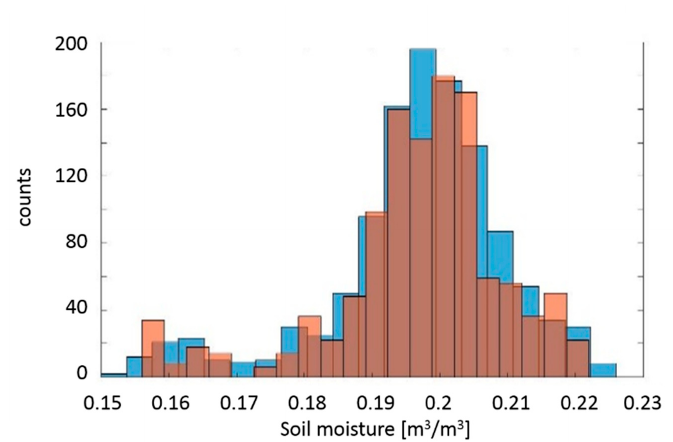
Figure 13. Matched histograms of downscaled ARIEL SM values (blue), and CORTO GNSS-R-derived values (brown).